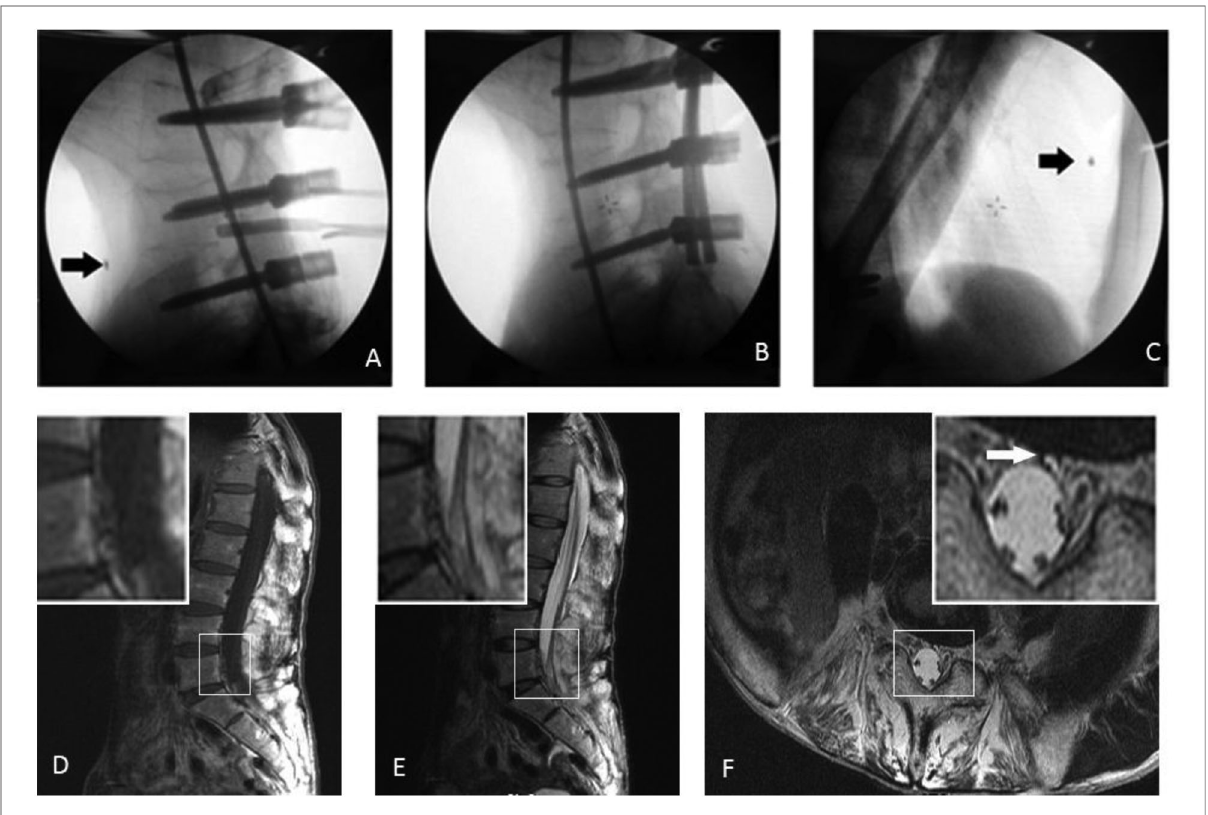
FIGURE 3 Intraoperativex-ray revealed that the broken metal tip (arrow) was located in the right anterior between the fourth and fi fth lumbar vertebrae ( A ). After L2 vertebral body osteotomy, the metal fragment was found to migrate to the heart ( B,C ). MR imaging showed abnormal internal vertebral venous plexus in the dorsal part of the 5th lumbar vertebral body, on T1W ( D ), T2W ( E ), and axial ( F ) images. MR, magnetic